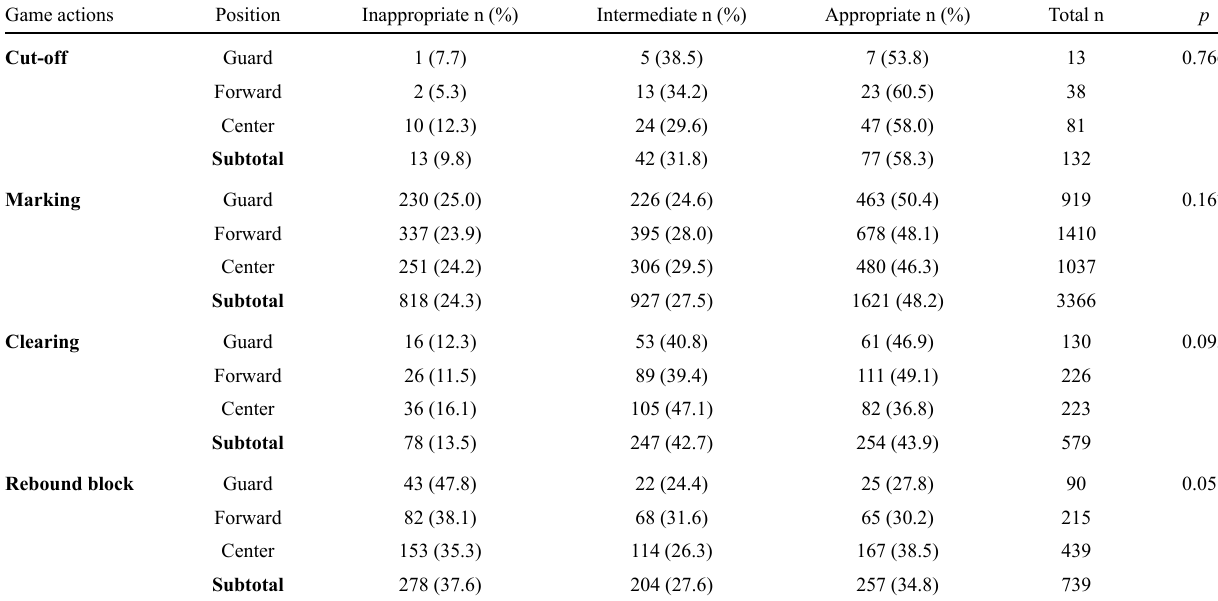
Table 2 - Adaptation level in game actions, considering the players’ positions. Game